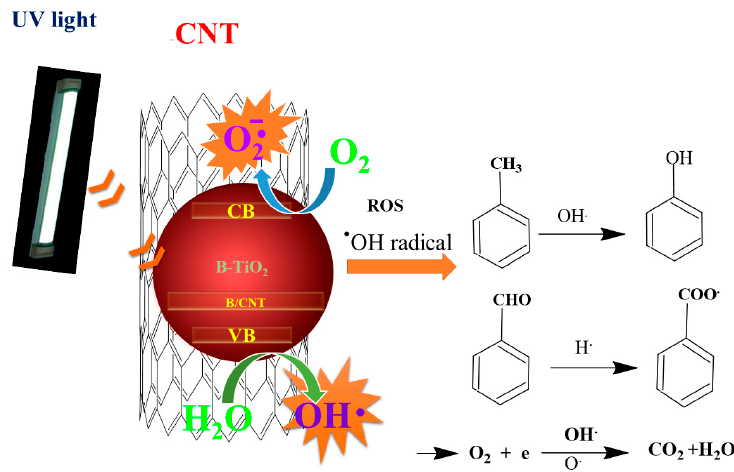
Figure 8. Possible photocatalytic degradation mechanism of toluene gas with B-TiO 2 -CNT nanocomposites under UV light.